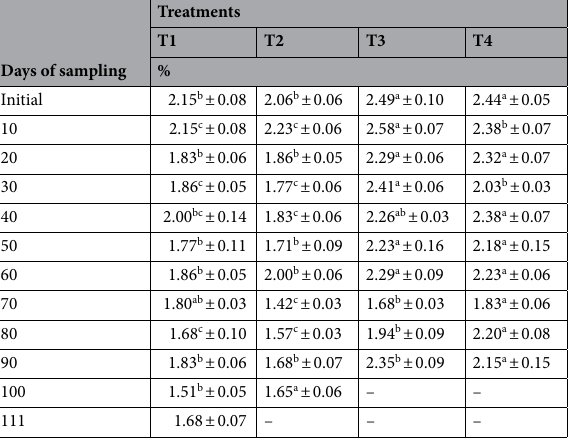
Table 5. Chicken litter biochar on total carbon in one hundred and eleven days growth of MR219. Different letters within a row indicates significant difference between means of four replicates ± standard error using Tukey’s test at p ≤